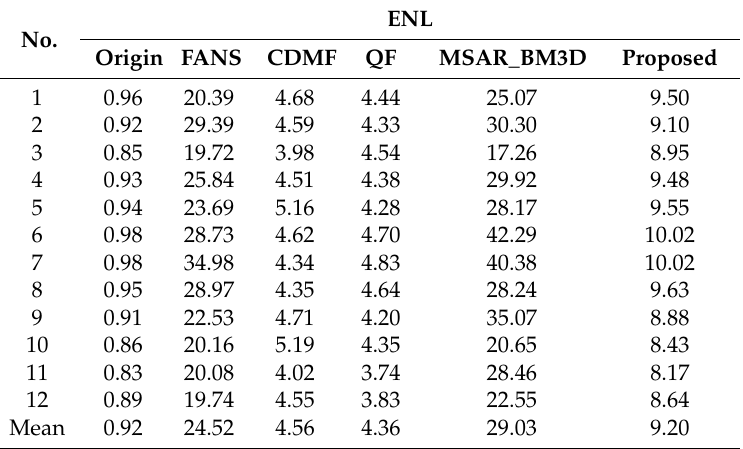
Table 5. The quantitative comparison of different filtering results for Dataset 2 (ENL).